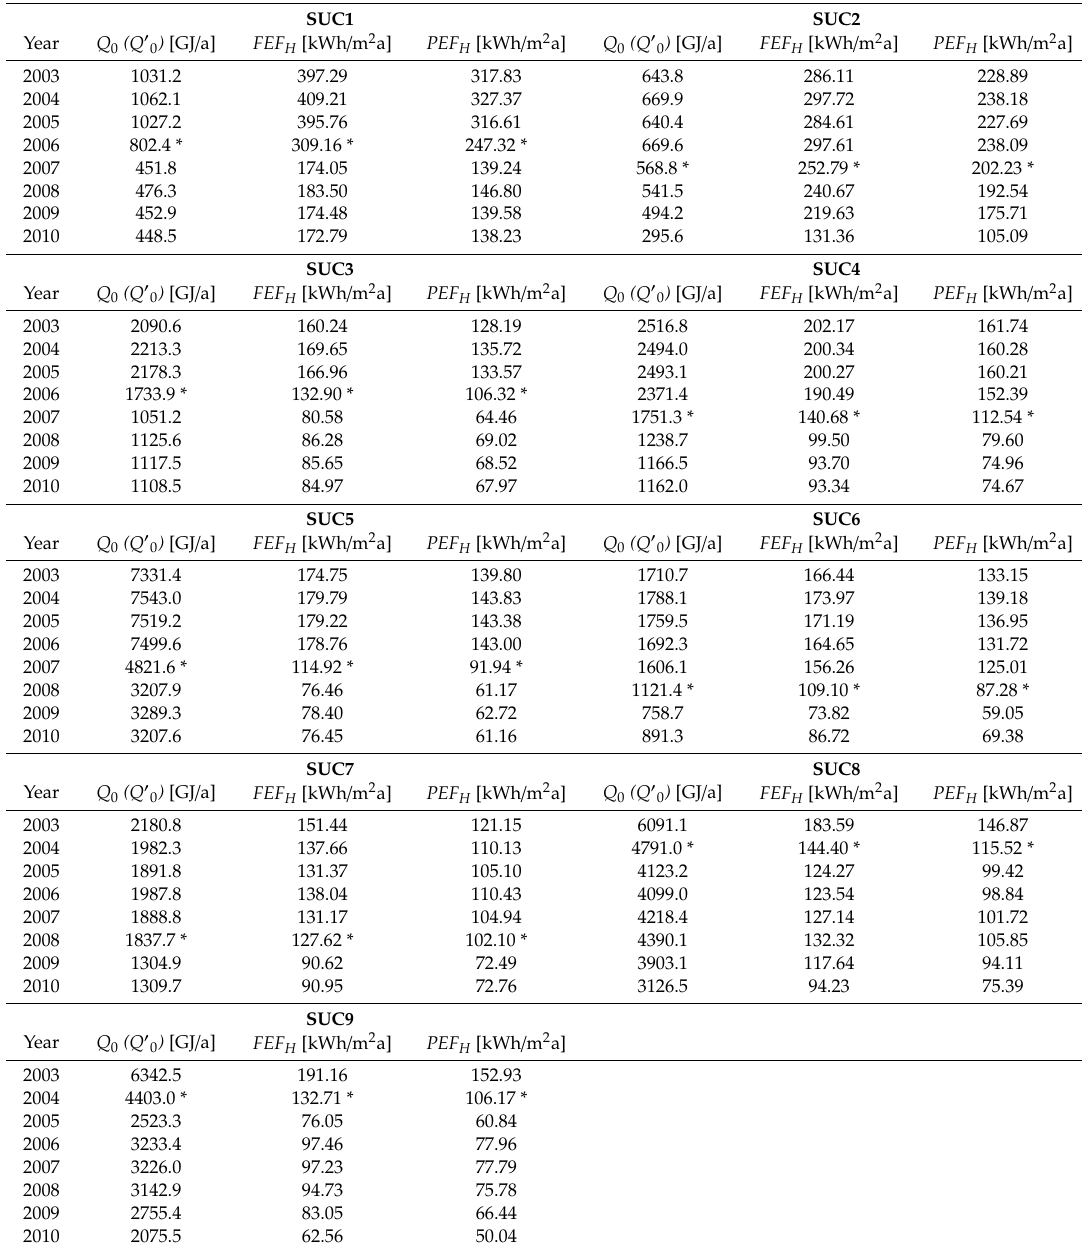
Table 5. Adjusted Annual Energy Consumption (AECH), Final Energy Factor (FEF) and Primary Energy Factor (PEFH) for heating achieved from the heat meter readouts in the particular year of the